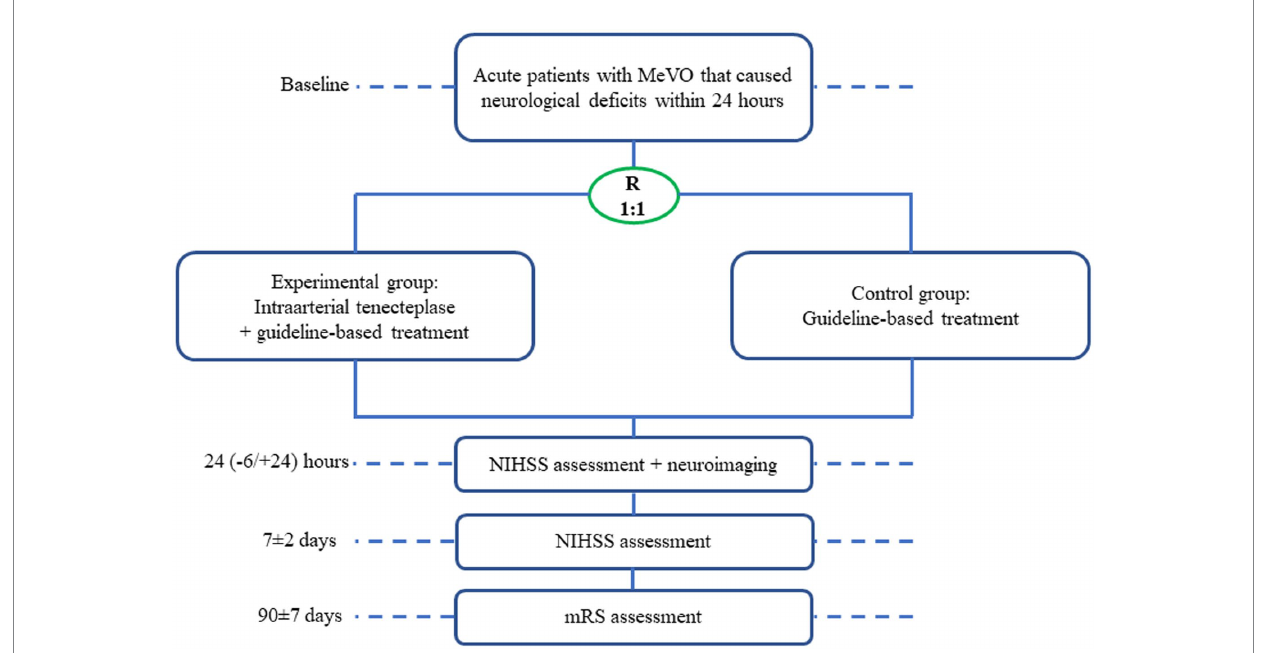
FIGURE 1 Trial flowchart. R, randomization; NIHSS, national institutes of health stroke scale; mRS, modified ranking